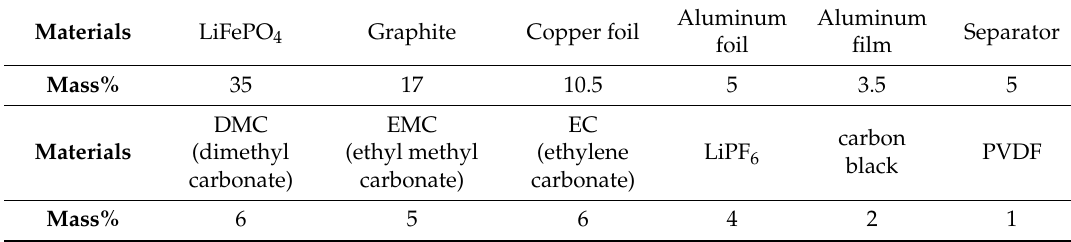
Table 2. The bill of materials of a LiFePO 4